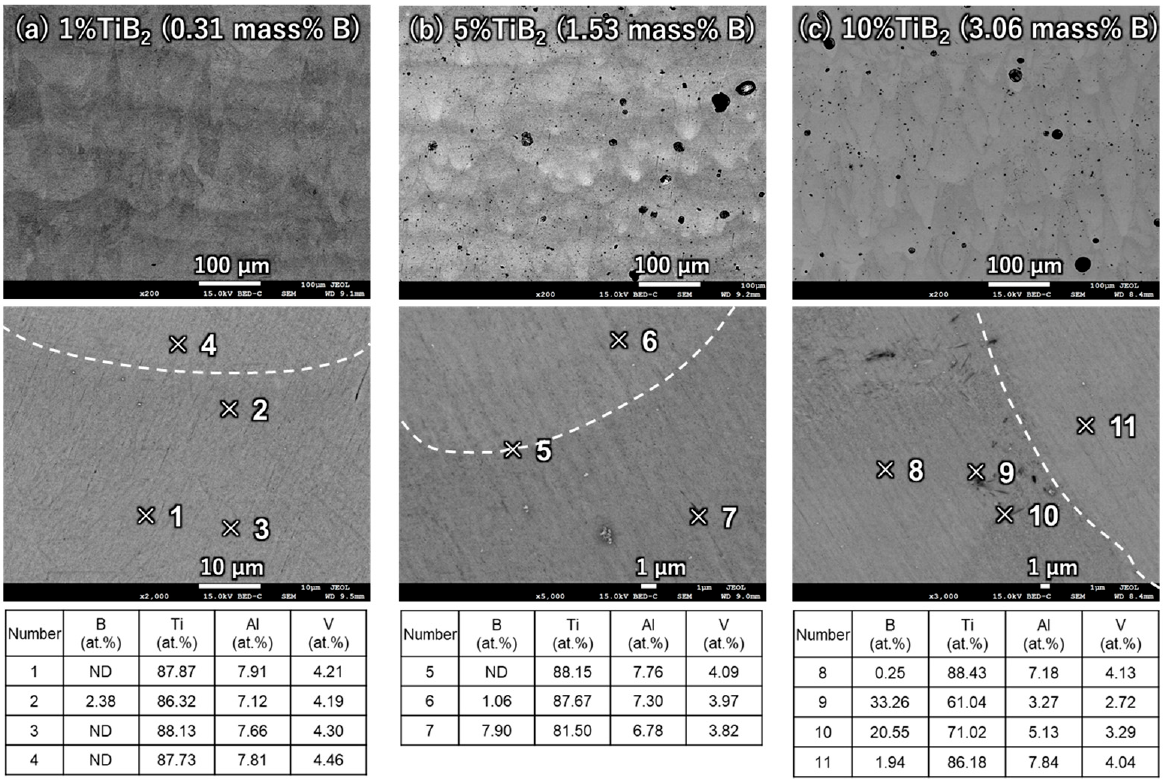
Figure 4. Compositional images (COMPO) and quantitative SEM-EDS analysis of SLM Ti64- ( a ) 1, ( b ) 5, and ( c ) 10 mass% TiB 2 alloy composites.